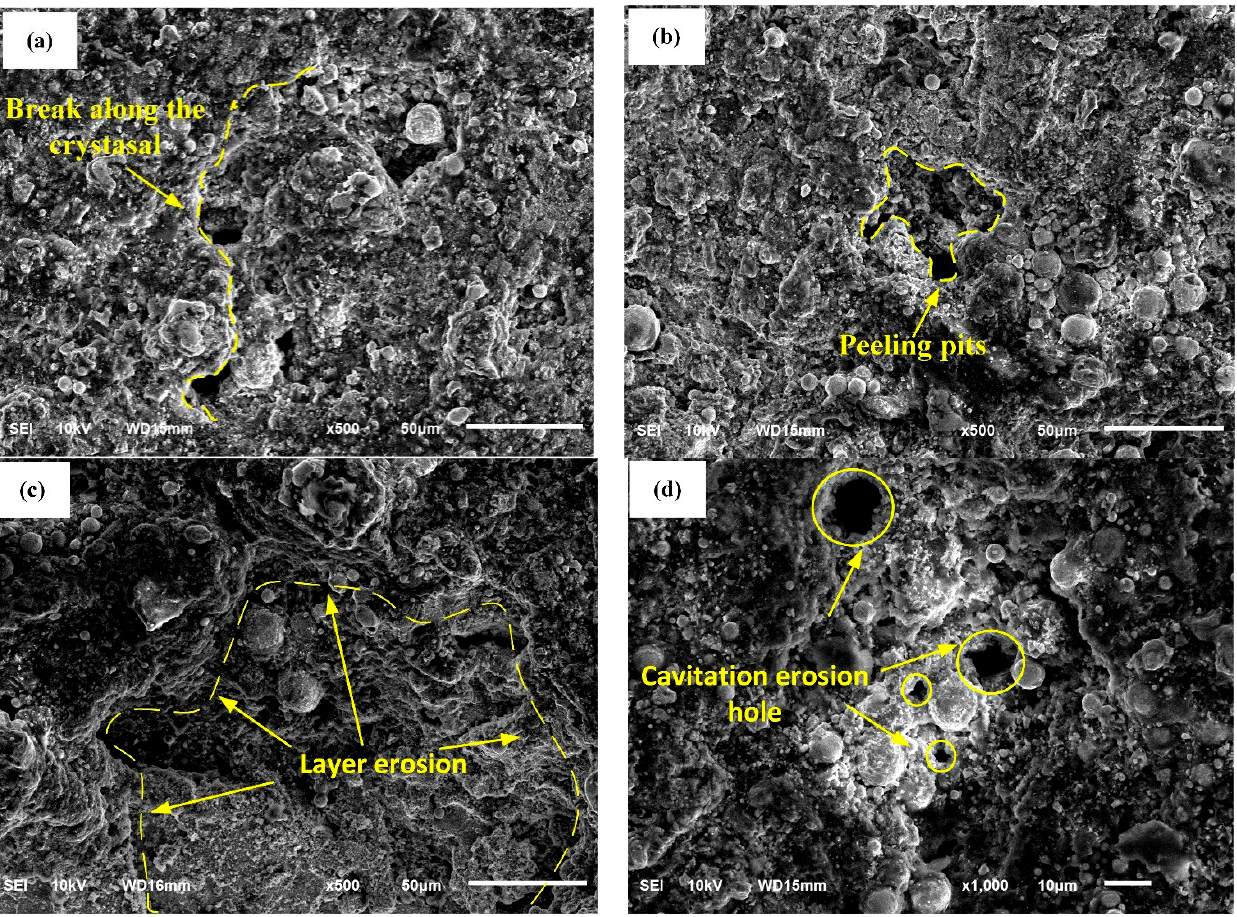
Figure 13. SEM images of material surface fracture after erosion: ( a ) fracture along crystals; ( b ) peeling pits; ( c ) layer erosion; ( d ) cavitation erosion hole.